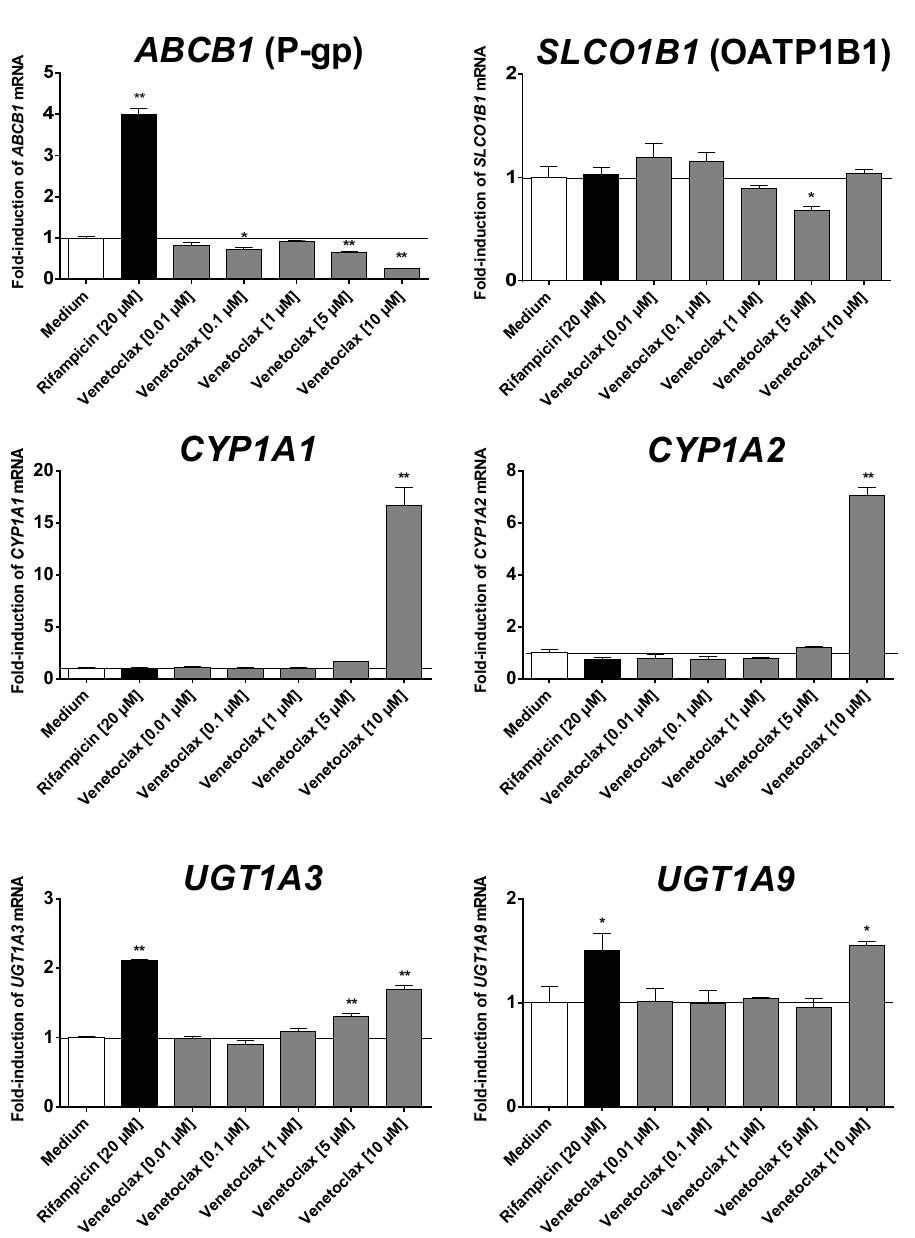
Figure 2. Induction assay. Concentration-dependent effect of venetoclax (0.01–10 µM) and 20 µM of rifampicin (positive control for PXR-driven genes) after four days on mRNA expression in LS180 cells compared to untreated medium control. Expression data were normalized to the housekeeping gene β 2mg . Data are expressed as mean ± SEM for n = 5 biological replicates and normalized to the medium control (set to 1). Differences in mRNA expression to the medium control were tested using ANOVA with Dunnett’s post hoc test. * p < 0.05, ** p < 0.01.